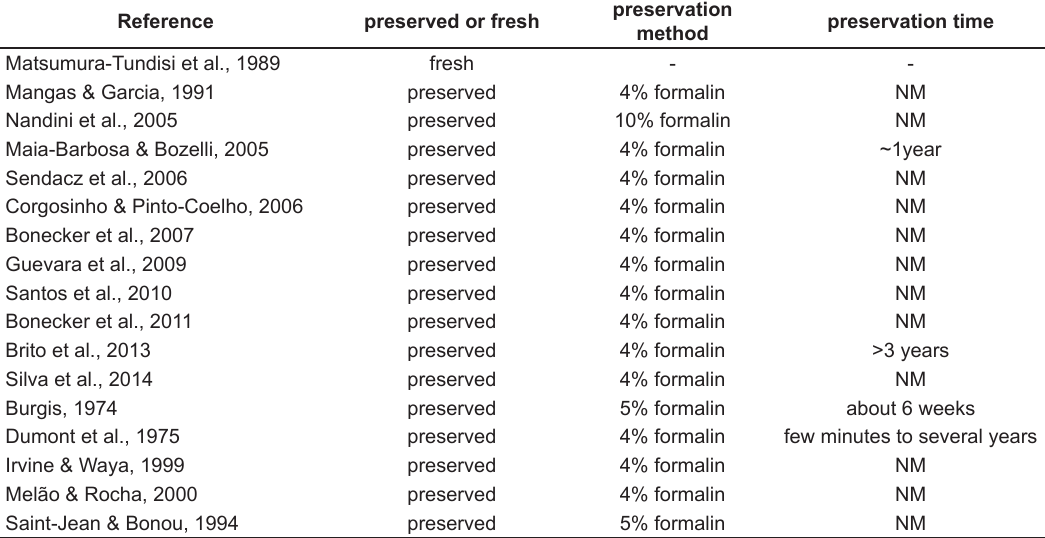
Table 1. Previous studies using fresh or formalin-preserved specimens of freshwater cladocerans. NM = not